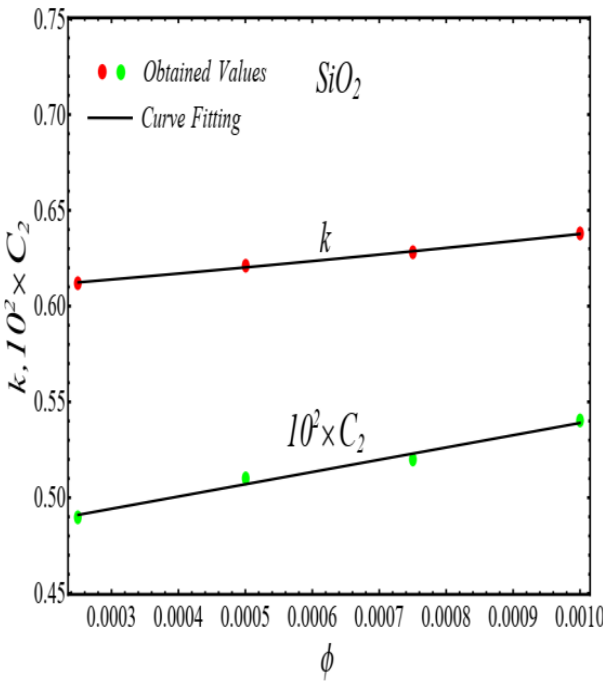
Figure 13. Fitting of the Equation (4) for parameters listed in Table 3.